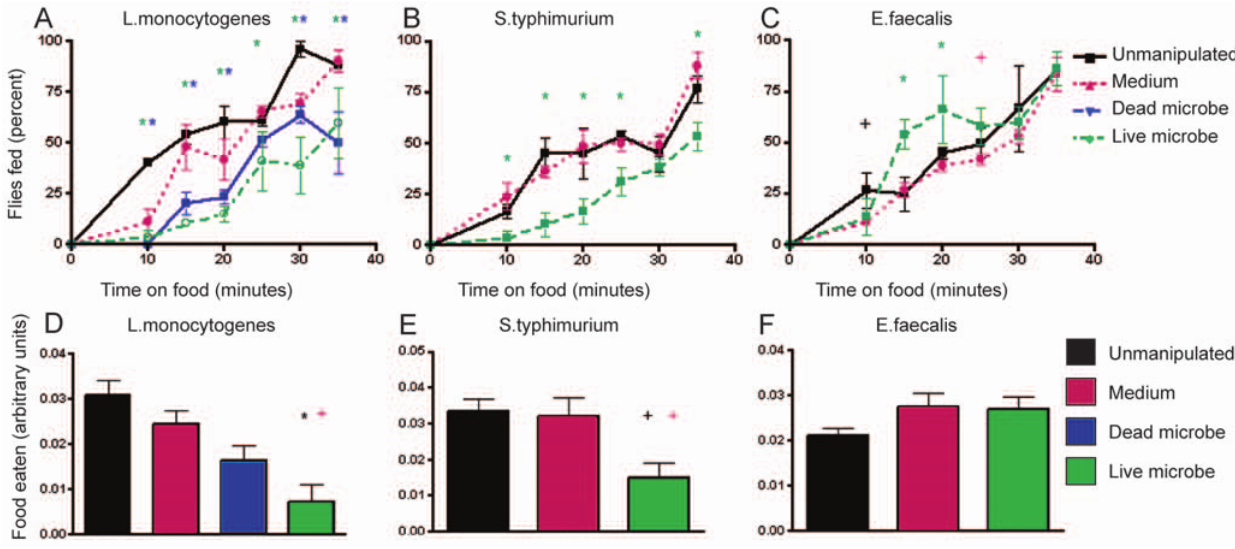
Figure 1. Effect of infection on appetite. Flies were infected with live or heat killed L. monocytogenes , live S. typhimurium , live E. faecalis , medium as a control, or left unmanipulated. Feeding was monitored by measuring the rate that flies took a meal (A–C) and the volume that they consumed during this meal (D–F). Feeding rate measurements: (A) L. monocytogenes 24 h postinfection; (B) S. typhimurium 24 h postinfection; (C) E. faecalis 24 h postinfection. To measure the volume of food consumed, fed flies were homogenized and the absorbance of an added blue dye was measured 24 h postinfection. (D) L. monocytogenes , (E) S. typhimurium , (F) E. faecalis . Error bars indicate standard error of the mean. Significance for (A–C) was assessed using a Fisher’s exact test. Green asterisks represent live bacteria significantly different compared to both unmanipulated and media- injected flies. Blue asterisks represent dead bacteria ( L. monocytogenes only) significantly different than both unmanipulated and media-injected flies. Black cross represents live bacteria significantly different from unmanipulated flies only. Pink cross represents live bacteria significantly different from media-injected flies only. Actual p -values are listed in Tables S1, S2, S3. Statistical analysis for (D–F) was done using ANOVA and a Tukey post-test; black asterisk indicates p , 0.01 with respect to both unmanipulated and media-injected flies, black cross indicates p , 0.05 with respect to unmanipulated flies only, and pink cross indicates p , 0.05 with respect to media-injected flies only.